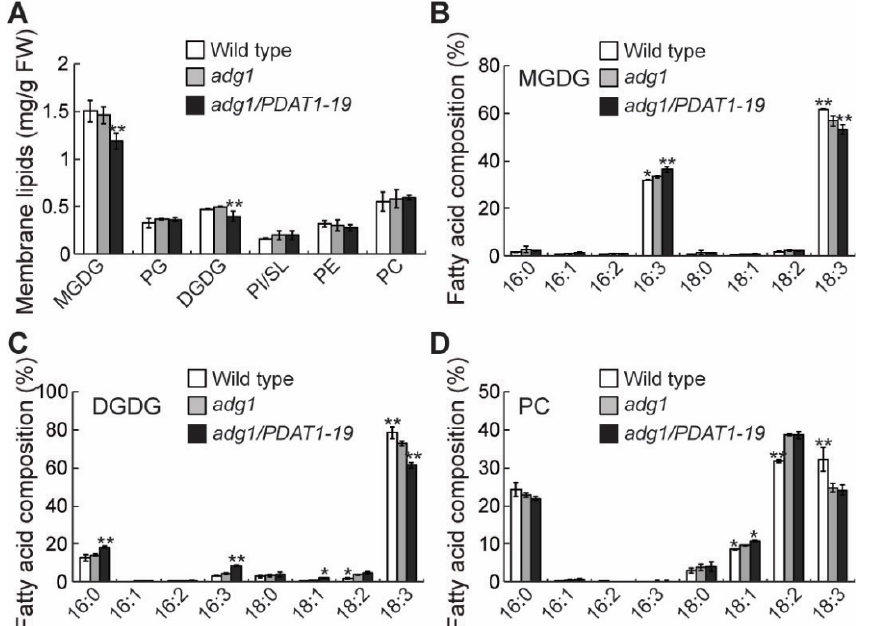
Figure 4. Membrane lipid content ( A ) and fatty acid composition of MGDG ( B ), DGDG ( C ) and PC ( D ) in leaves of six-week-old plants grown on soil. Asterisks indicate statistically significant differences from adg1 based on Student’s t test (* P < 0.05, ** P < 0.01).